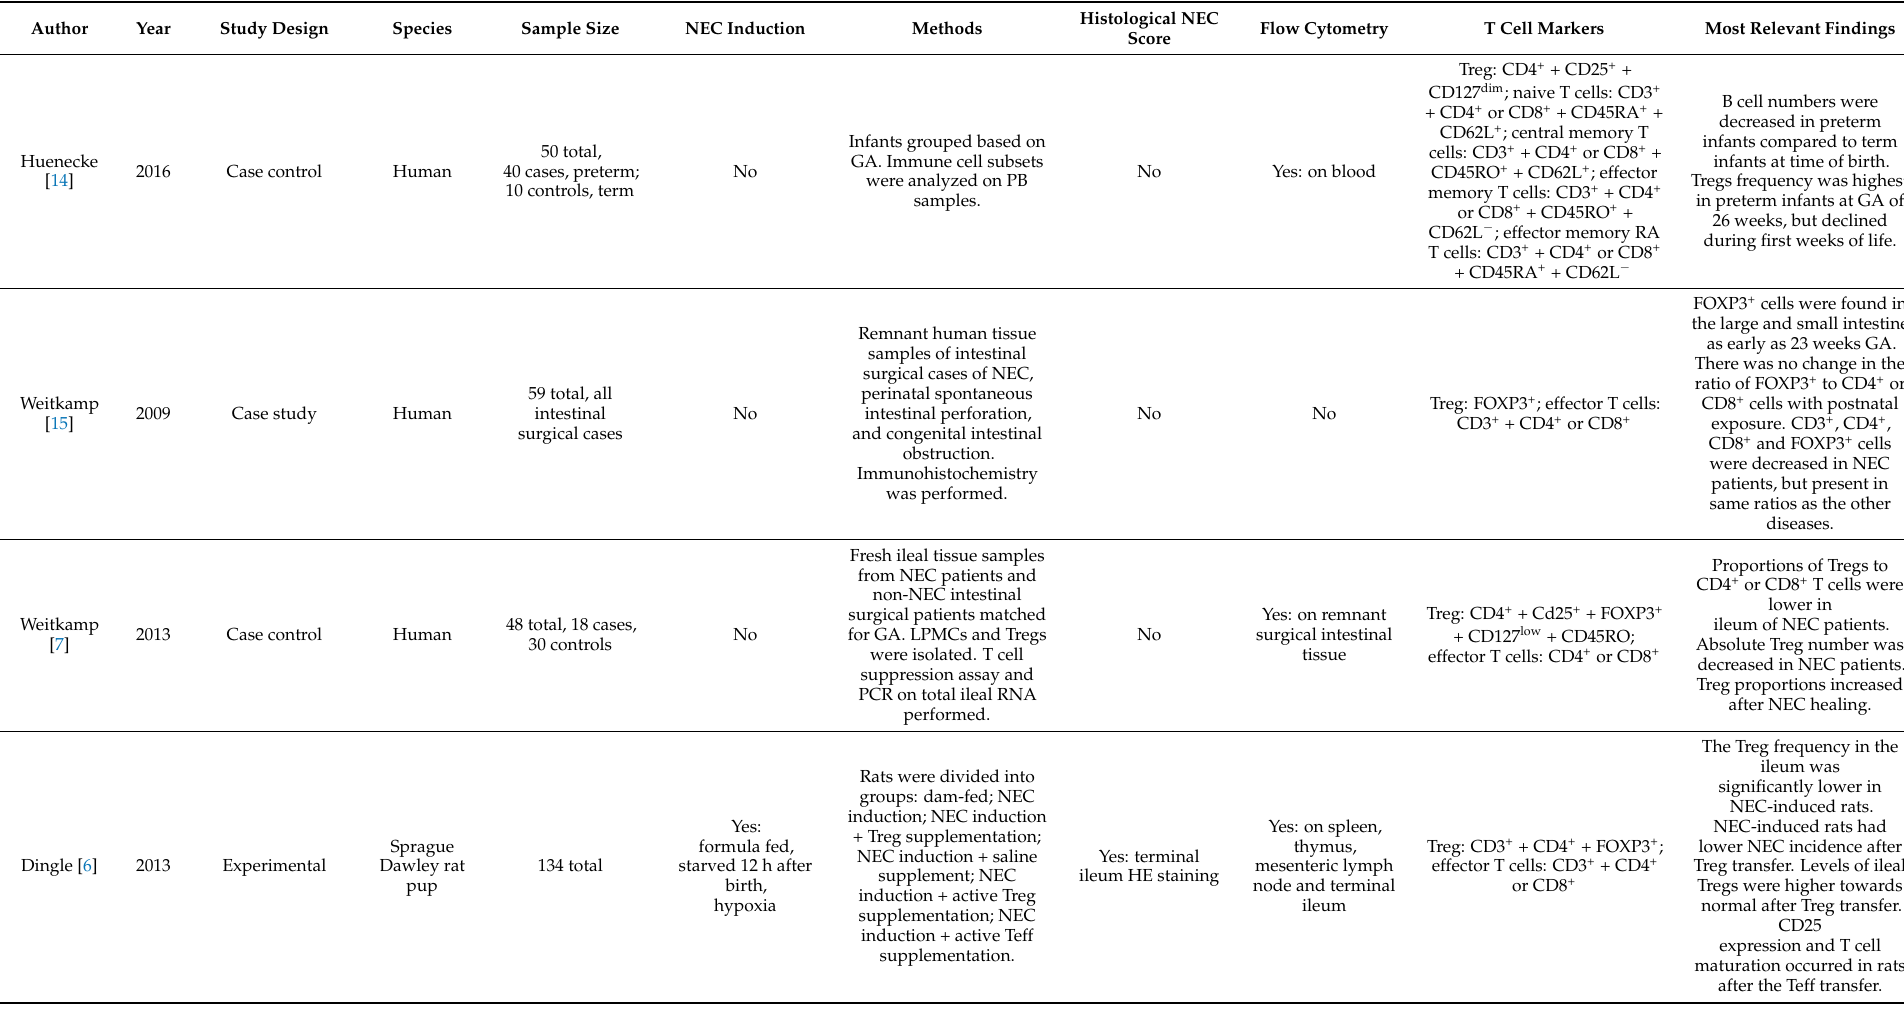
Table 1. Characteristics and main findings of included T cell related